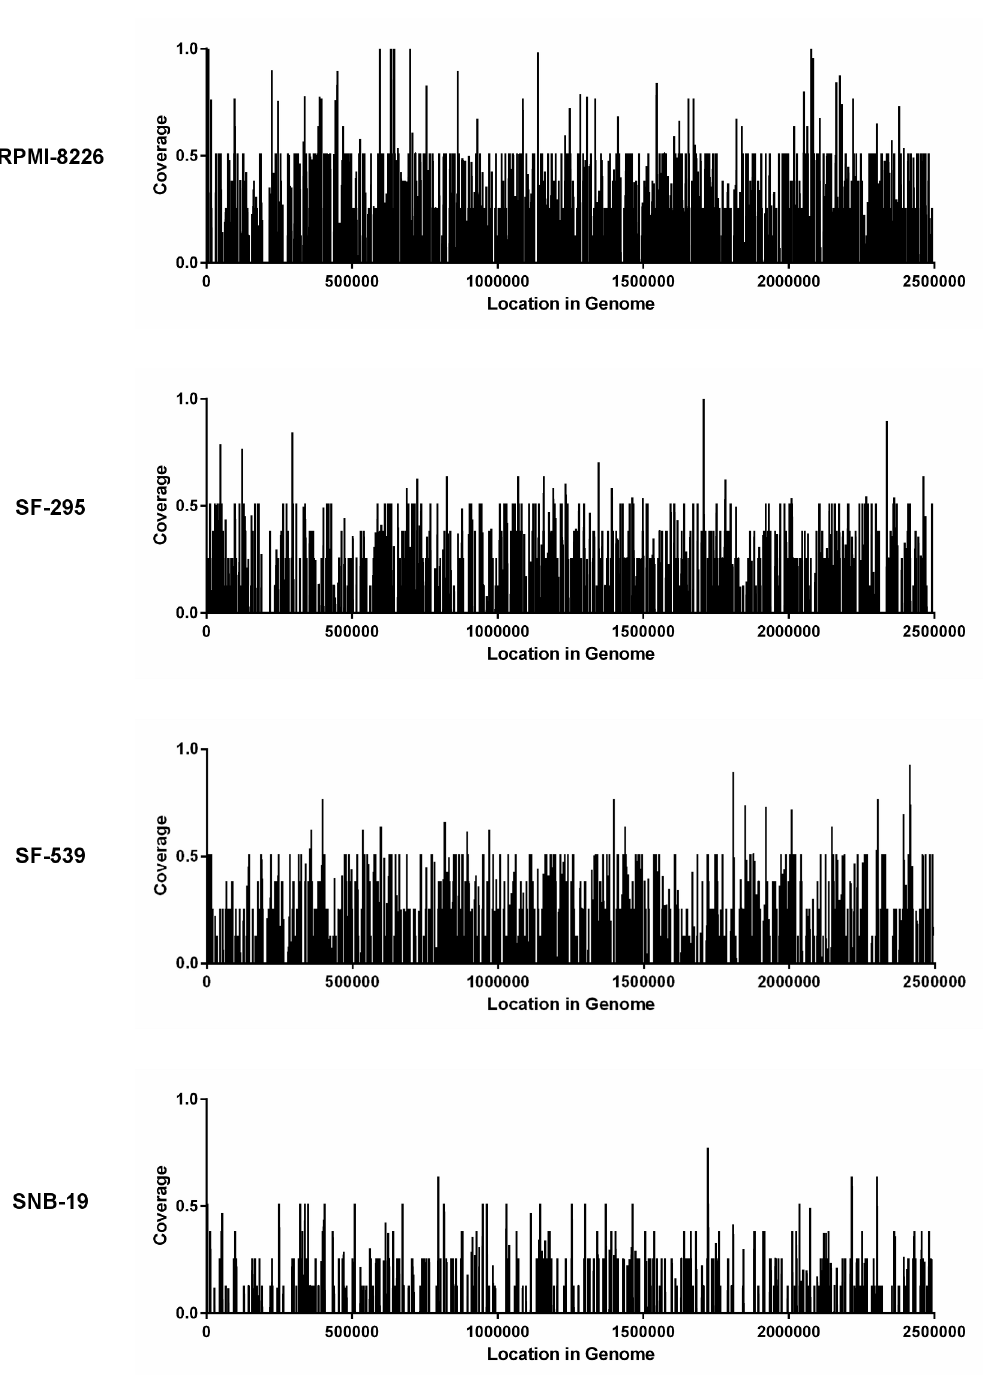
Fig 3. Average windowed nucleotide coverage for P. acnes HL096PA1. Average window-by-window nucleotide coverage (window size = 250 bases) of the P. acnes HL096PA1 (NC_021085.1) genome by 32-base long subsequences acquired from leukemia (RPMI-8226) and central nervous system (SF-295, SF-539, and SNB-19) sequencing datasets. The average nucleotide coverage per window is equal to the total number of reads that map (cover) each position within the given window divided by the window size (250).